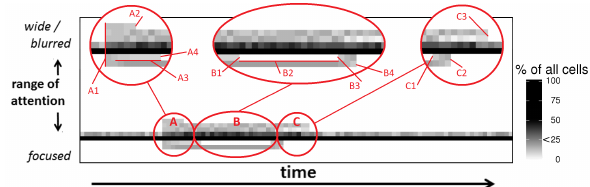
Figure 4: The reaction of the cell population to triggers after the population has reached the steady state shown at the far right end of Figure 3. Shown is the frequency distribution of observed focus levels (y-axis, going from extreme wide focus , top, to highly fo- cused , bottom) over time (x-axis). The results shown were obtained from simulating 400 cells. The cell population starts out converged to a stable condition. Triggers are introduced in A and focus require- ments are met. Localised increased focus is maintained throughout B until the triggers are removed in C , allowing the population to re- turn to the initial stable condition. In detail: after the introduction of the triggers a portion of the cells either increase their focus or widen it ( A ). Some cells widen their focus more than strictly neces- 1 sary but this is optimised and by A their focus is increased again. 2 Similarly, too many cells react to the triggers by increasing their focus. In this case it takes a bit longer for the cells to optimise ( A ). 3 At A / B a stable (and near optimal) configuration is reached. For 4 1 the duration of B the focused cells do not change. After the triggers 2 are removed at B / C the focused cells gradually widen their focus 3 1 again until B / C . As before and because focusing takes longer than 4 2 unfocusing, it takes the cells with wider focus a bit longer to settle back into the stable initial condition ( C ). 3